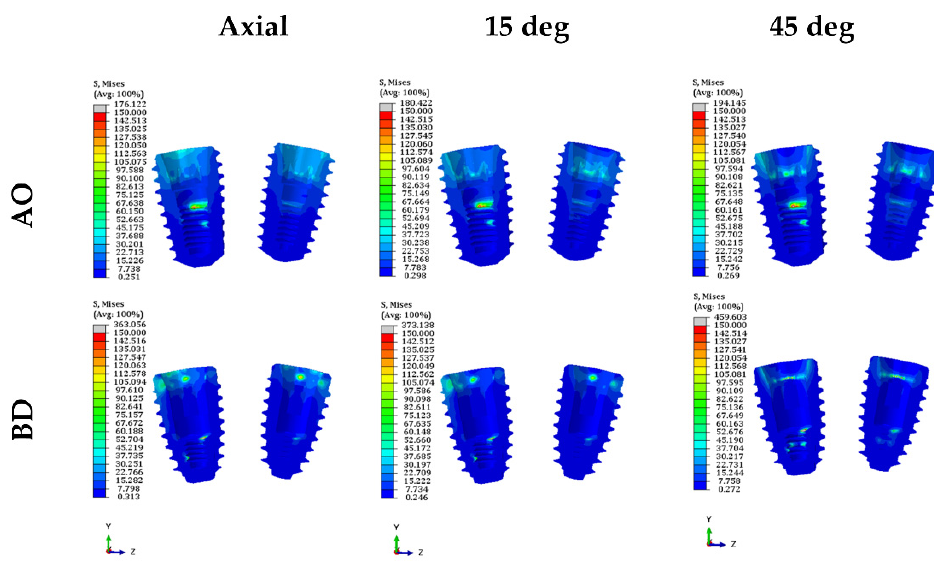
Figure 10. Stress distribution diagram of the abutment in both models.